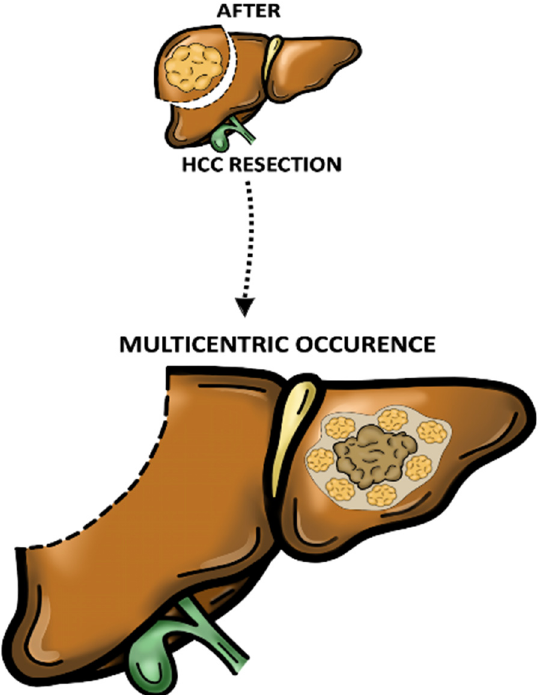
Figure 2. Multicentric occurrence (MO). Multiple nodular disease with well-differentiated carcinoma surrounding a less-differentiated mass (known as “nodule in nodule” form).